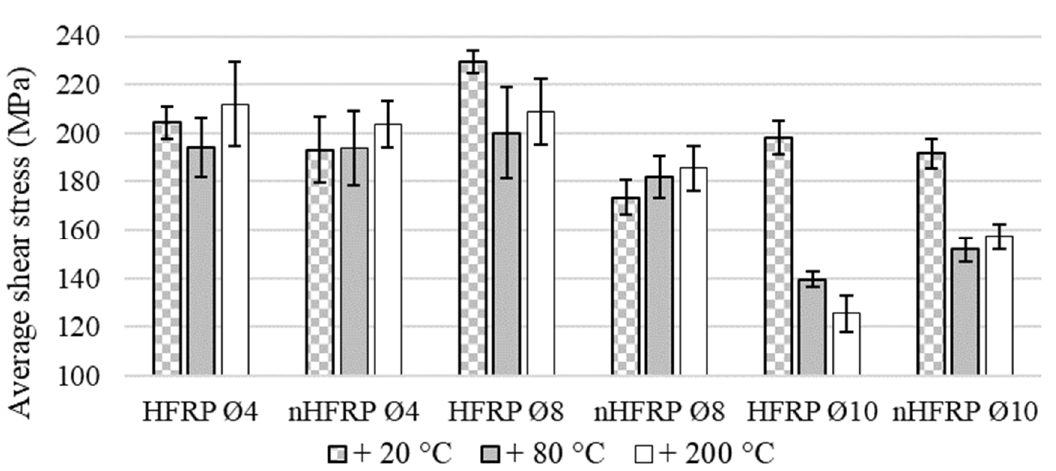
Figure 6. Comparison of the average shear strength for nanosilica modified bars, nHFRP, and unmodified HFRP with average shear strengths, standard deviation (SD).